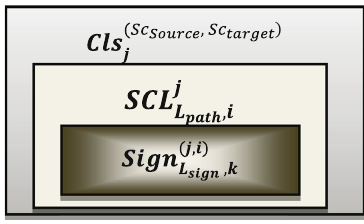
Figure 2: Equivalence classes, equivalence subclasses,